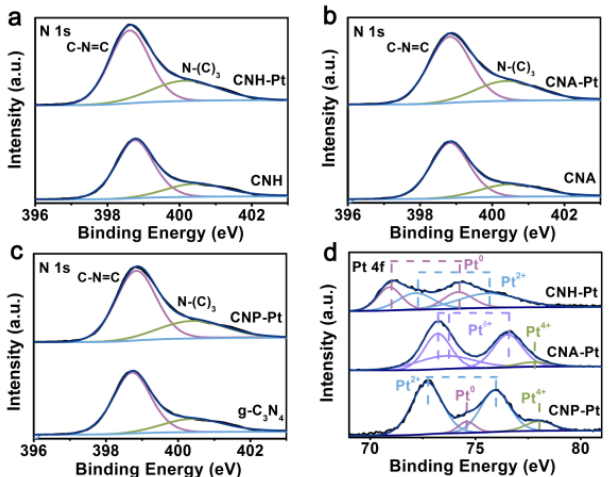
Figure 3. XPS spectra of N 1s of CNH-Pt and CNH ( a ), CNA-Pt and CNA ( b ), CNP-Pt, and g-C 3 N 4 ( c ). ( d ) Pt 4f spectra of CNH-Pt, CNA-Pt, and CNP-Pt. ( d ) Pt 4f spectra of CNH-Pt, CNA-Pt, and